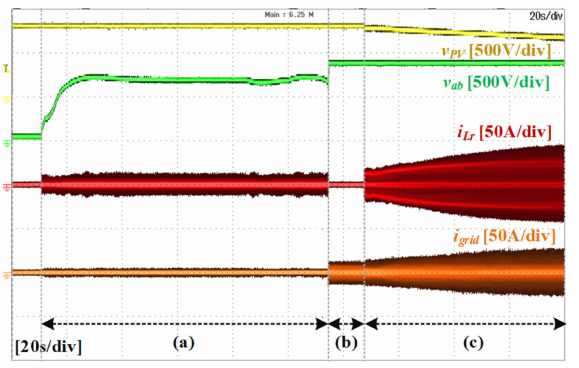
Figure 16. Experimental waveforms of the soft-start up and initial operation